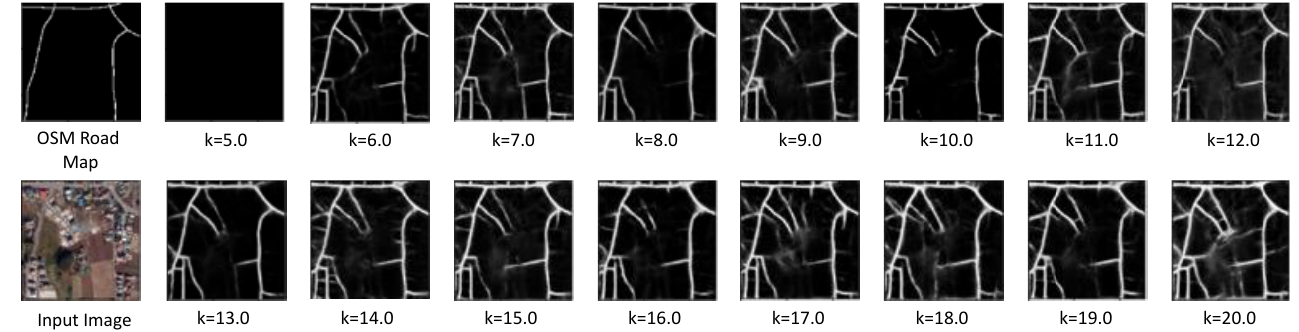
Figure 11. Transitions of loss and accuracy (F1 score) for different loss function weights: (a) k = 1.0 (same weight for roads and non-roads) and (b) k = 10.0 (10 times weight against roads).